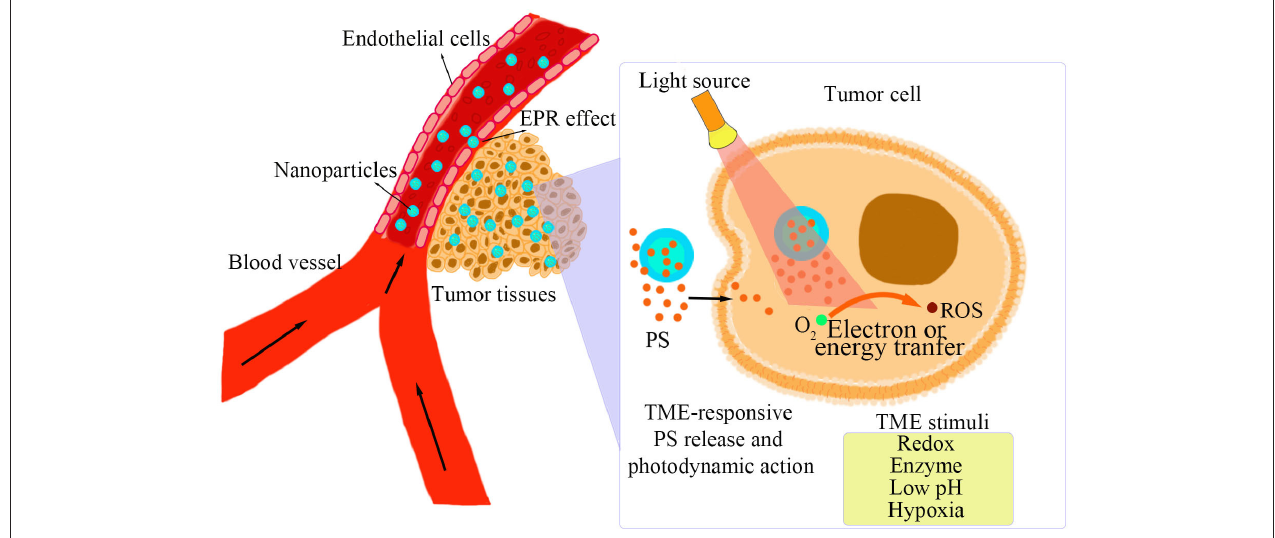
FIGURE 1 | TME-responsive PS release and photodynamic